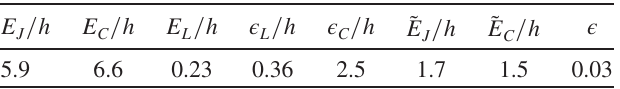
TABLE I. Extracted parameters for the circuit in Fig. 2. The final two energy scales correspond to the effective one-dimen- 0 in Eq. (8). All energy scales are sional Hamiltonian at θ ext ¼ given in gigahertz.